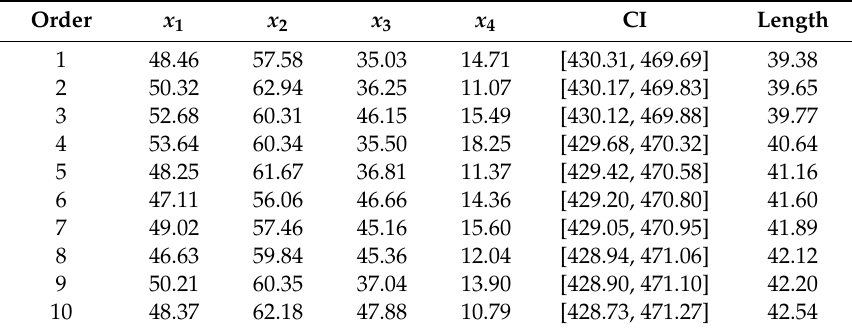
Table 7. ( y target = 450) Results of finding L’ = 10 solutions using the proposed